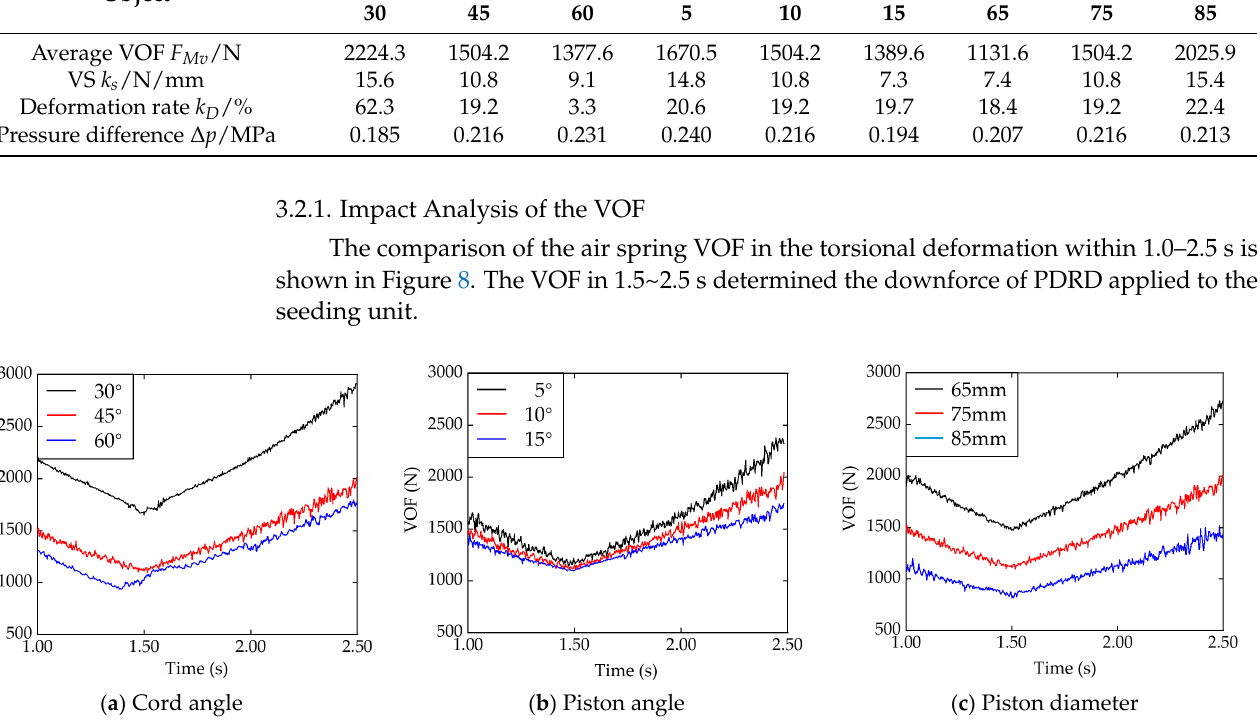
Figure 8. The VOF under different structural parameters.